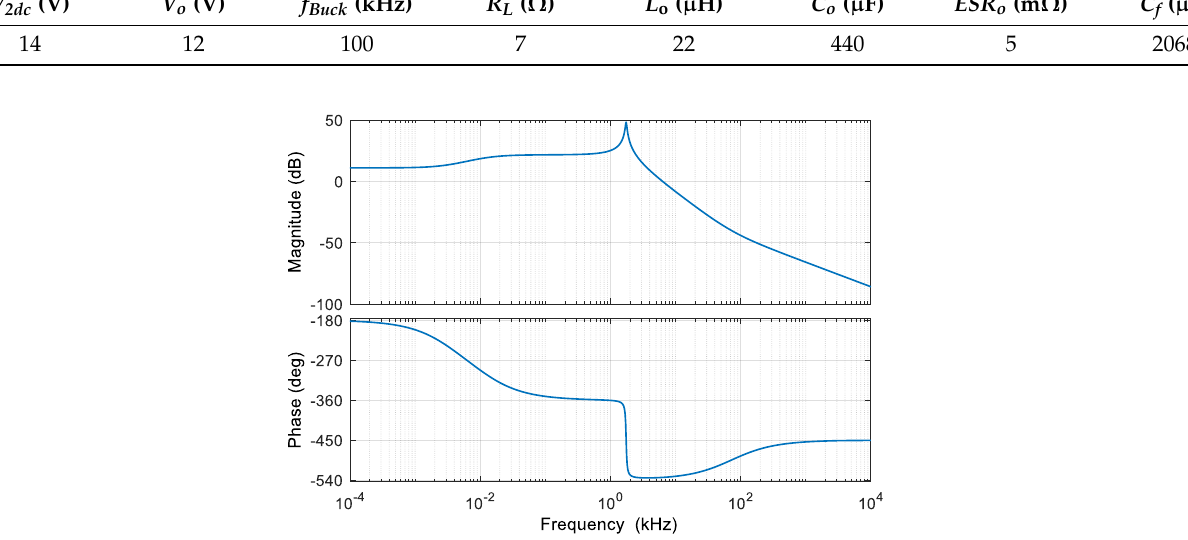
Figure 17. Bode plots of G vd ( s ) for { f s = 70 kHz, V 2 dc = 14 V}.